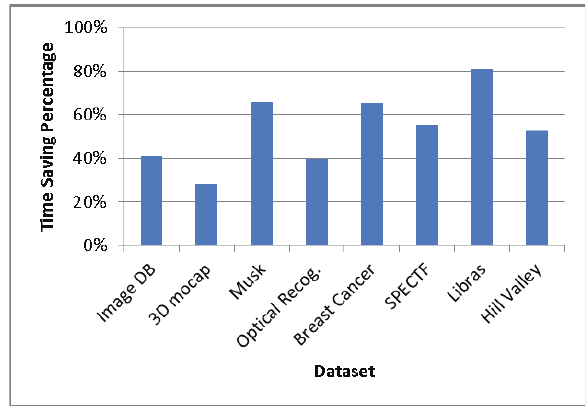
Fig. 7. Comparison of the classification execution time using the discovered contrast sets with the original feature vectors. Table 9. The time taken to mine the contrast sets of training datasets vs. the time taken to classify the test dataset (see Table